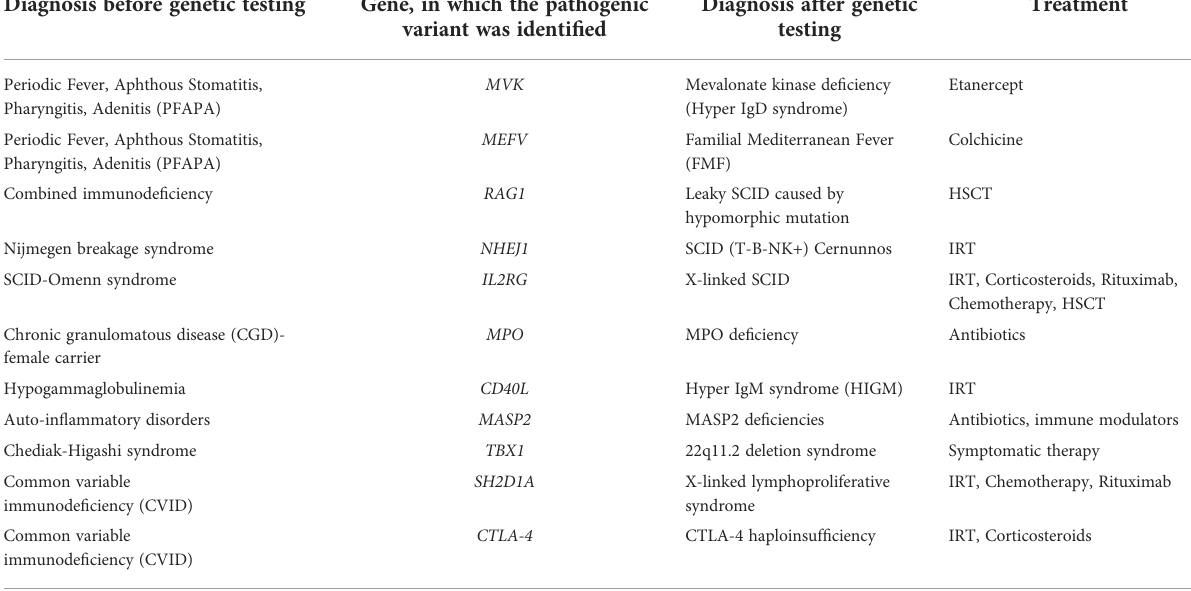
Diagnosis before genetic